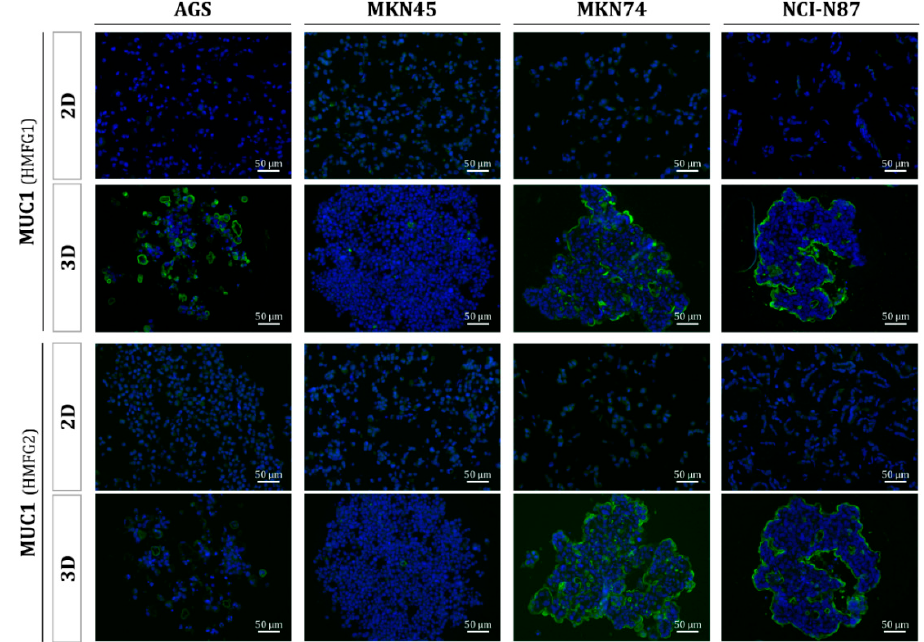
Figure 5. Mucin 1 (MUC1) expression in human gastric multicellular tumor spheroids. Immunofluorescent labelling of the MUC1 expression in gastric cancer cell lines grown in 2D or 3D cell culture methods using two different monoclonal antibodies (HMFG1 and HMFG2).